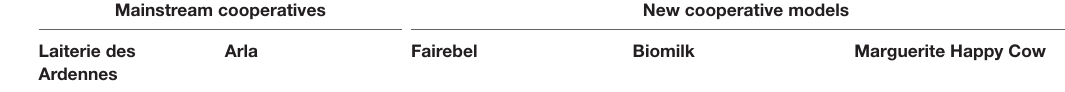
TABLE 5 | Summary of the features of interactions with business